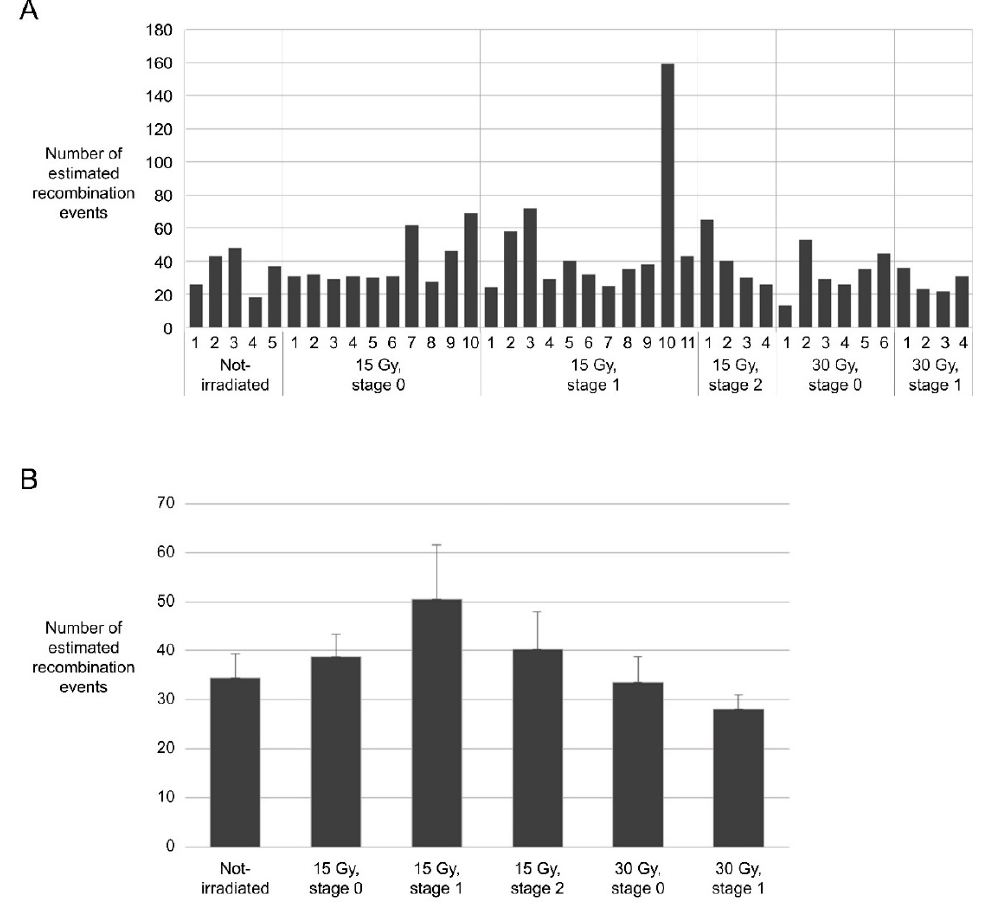
Figure 5. Estimated frequencies of recombination in progeny derived from gametophytes irradiated under different conditions. ( A ) Estimated frequency of recombination in each mutant line; ( B ) Average frequency of recombination estimated in progeny grouped on the basis of irradiation conditions.